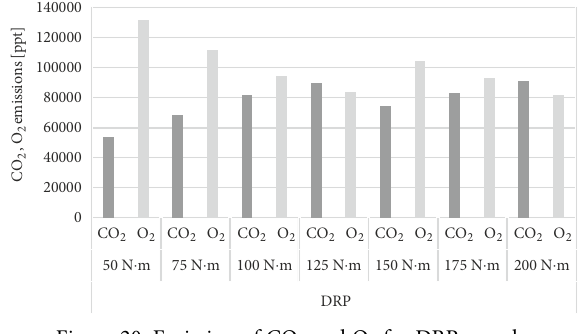
Figure 17. Emission of THC, NO x and CO for MD sample with operating parameters of engine 1500 rpm